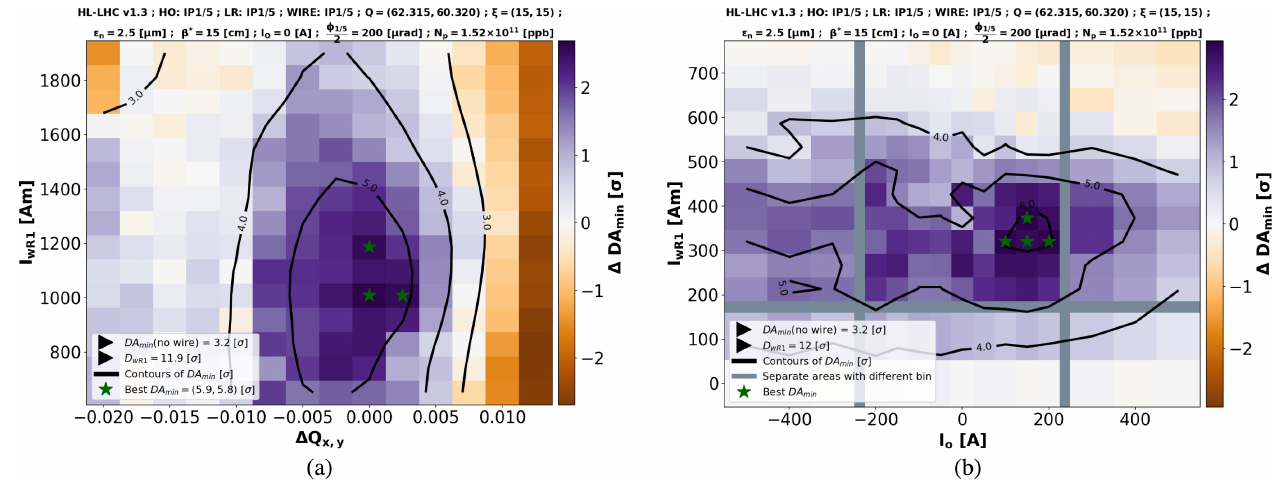
FIG. 9. HL-LHC at the end of luminosity leveling. (a) with half crossing angle at IP1 and IP5 200 μ rad and N p ¼ 1 . 52 × 10 11 ppb the Δ DA for different wire integrated current and working tunes. (b) with half crossing angle at IP1 and IP5 200 μ rad and N p ¼ min 1 . 52 × 10 11 ppb the Δ DA for different wire integrated current and different Landau octupole min